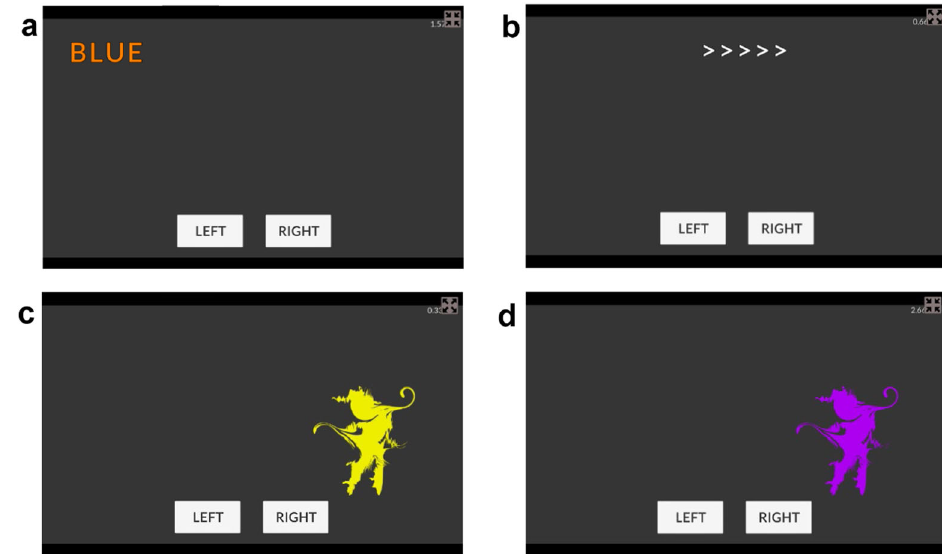
Fig. 3 | Illustrations of the non-gami fi ed tasks used in the fi nal experiment. Stroopon stimuli are colored words presented to left or right of display, the rele- vant information is stimulus color (i.e., orange): ( a ) double incongruent Stroopon trial (assuming blue=respond left; orange=respond right). Flanker stimuli are plain-colored arrows with the relevant information being the central arrow: ( b )